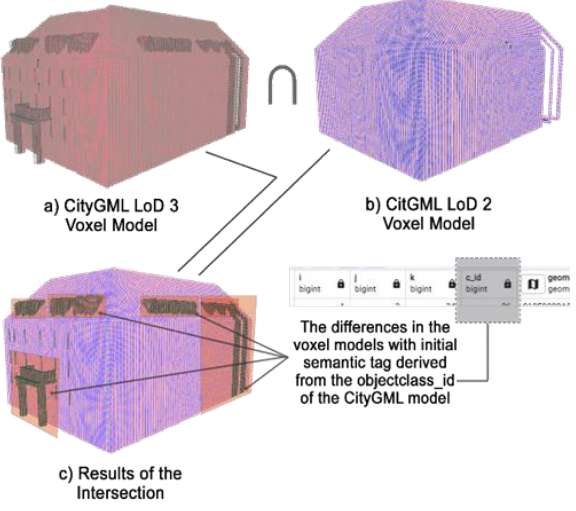
Figure 7 Comparison of Voxel models of LoD2 and LoD3 CityGML models from Ingolstadt,